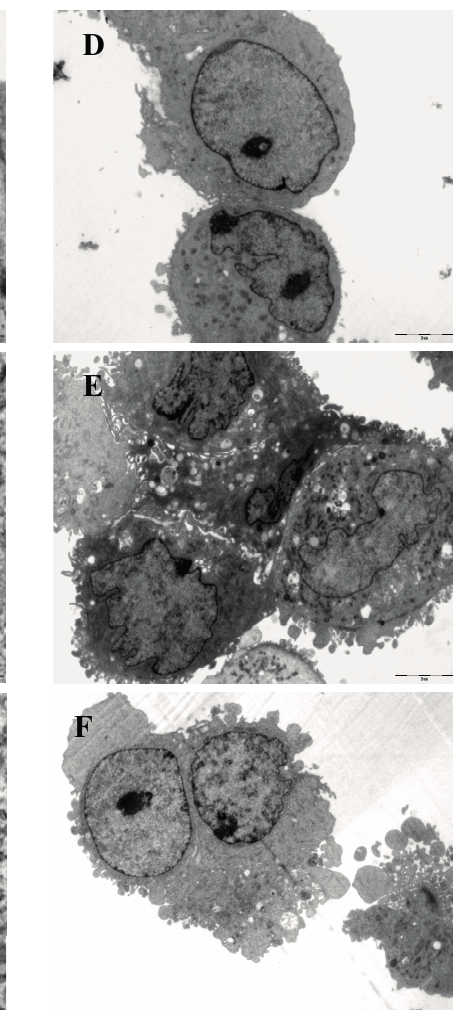
Figure 4. Electron microscopy analyses. NRK-52E cells were grouped and treated as in Figure 1 and examined under an electron microscopy after 48 h. ( A , D ) NG group; ( B , E ) HG group; ( C , F ) HG + GA group. A – C : ×4000, D – E :